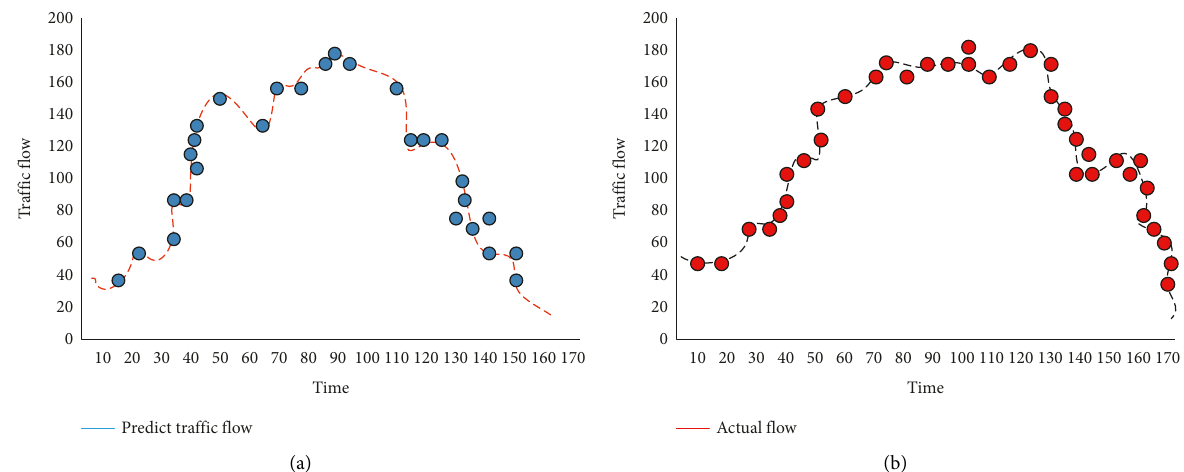
Figure 7: Statistical graph of predicted and actual traffic flow by K-means algorithm. (a) Prediction of traffic flow by K-means algorithm. (b) Actual flow of